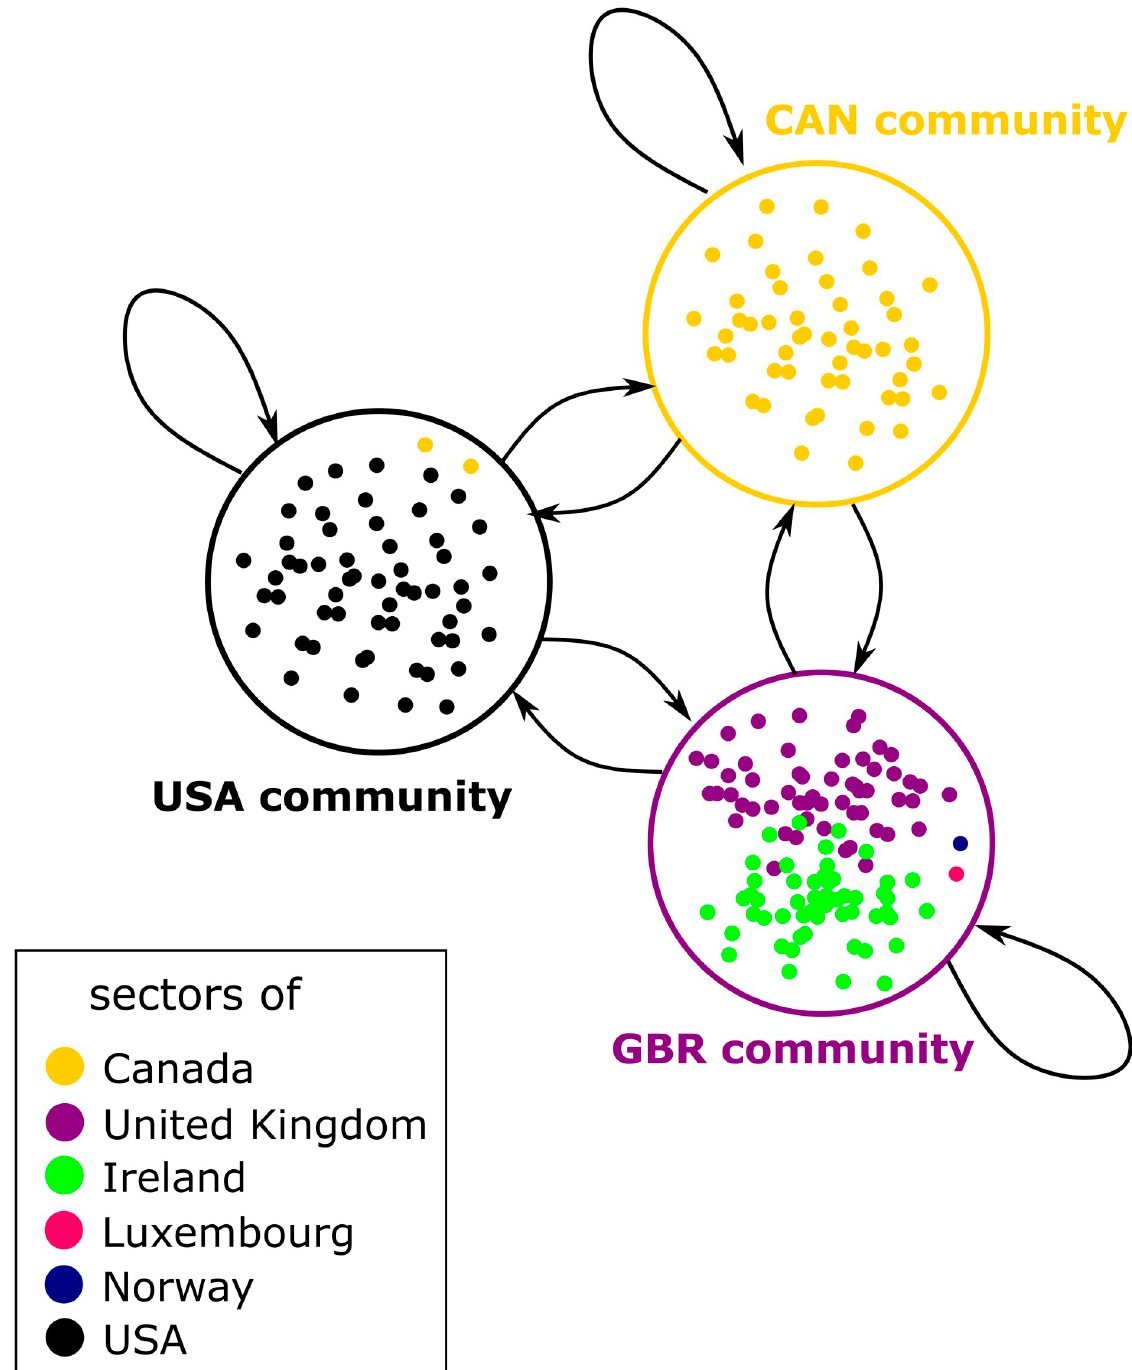
Fig 6. The fragment of world input output community network.